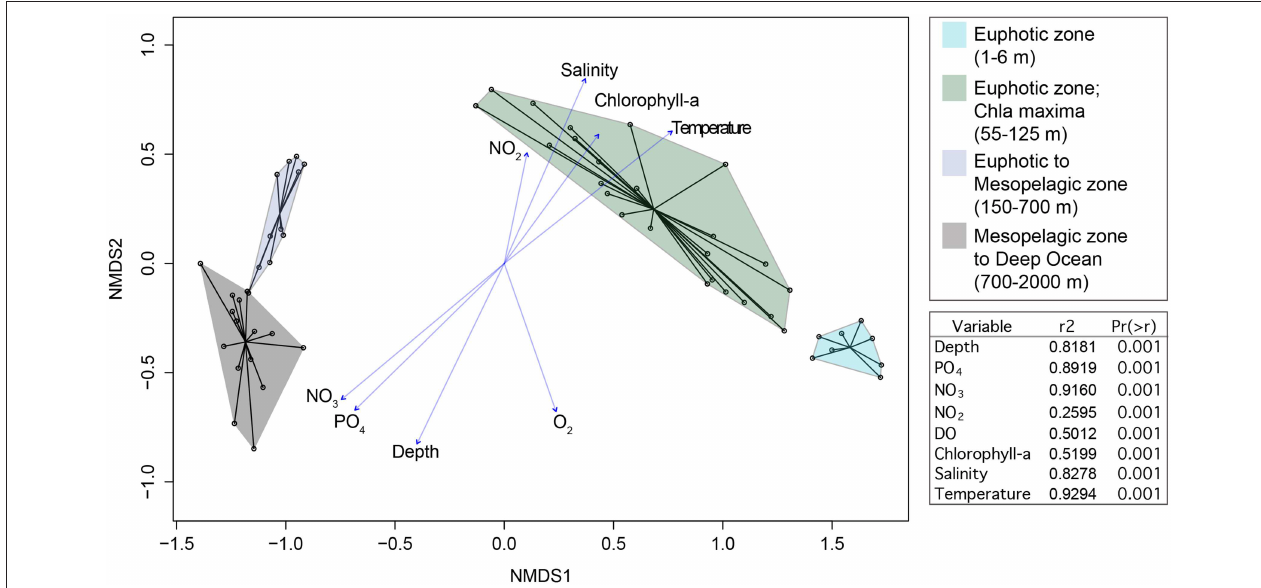
FIGURE 5 | NMDS ordination of relativized 16S rRNA gene iTag sequence data. Samples grouped by depth as shown in the ordination plot. Vectors are shown for environmental variables that were significantly correlated with NMDS ordination axes. Goodness of fit statistics (r2) and p -values are shown.